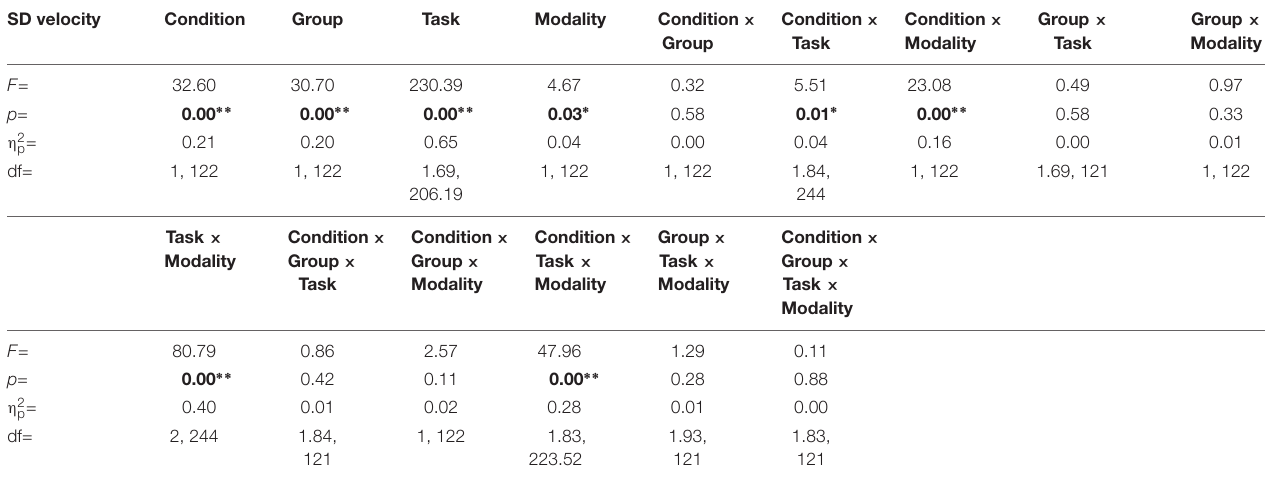
TABLE 2 | ANOVA results for SD velocity .